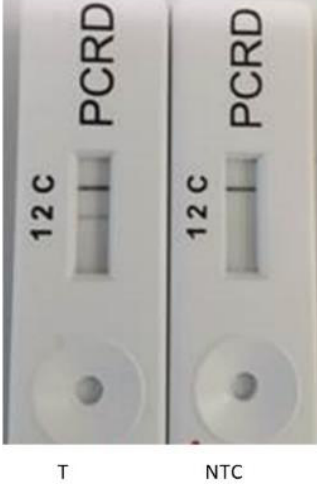
Figure 1. Screening of primers: Lanes 1 and 2—Ent rpoB F1/R1, Lanes 3 and 4—Ent rpoA F1/R1, Lane 5 and 6—Enttuf F1/R1, Lane 7 and 8—Enttuf F2/R2. Lane M—100 bp molecular ladder. (Note: primer concentration is − 10 µ M, template—2 µ L, assay temperature and time—38 ◦ C for 20 min).